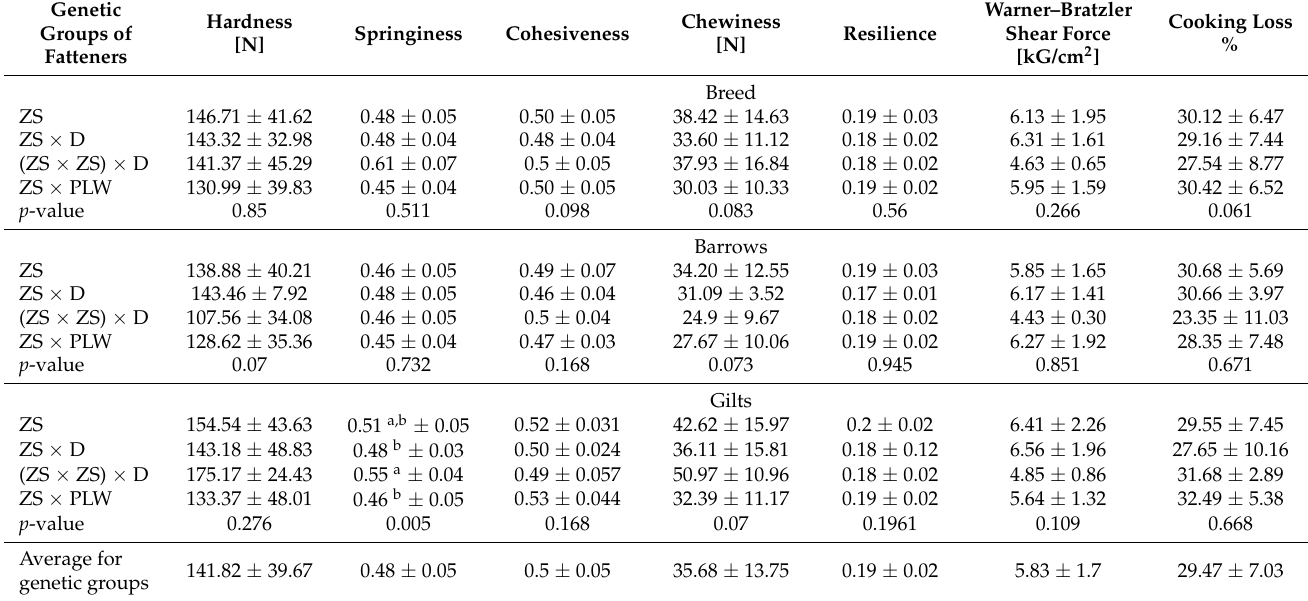
Table 6. Quality characteristics of the roasted loin m. longissimus thoracis